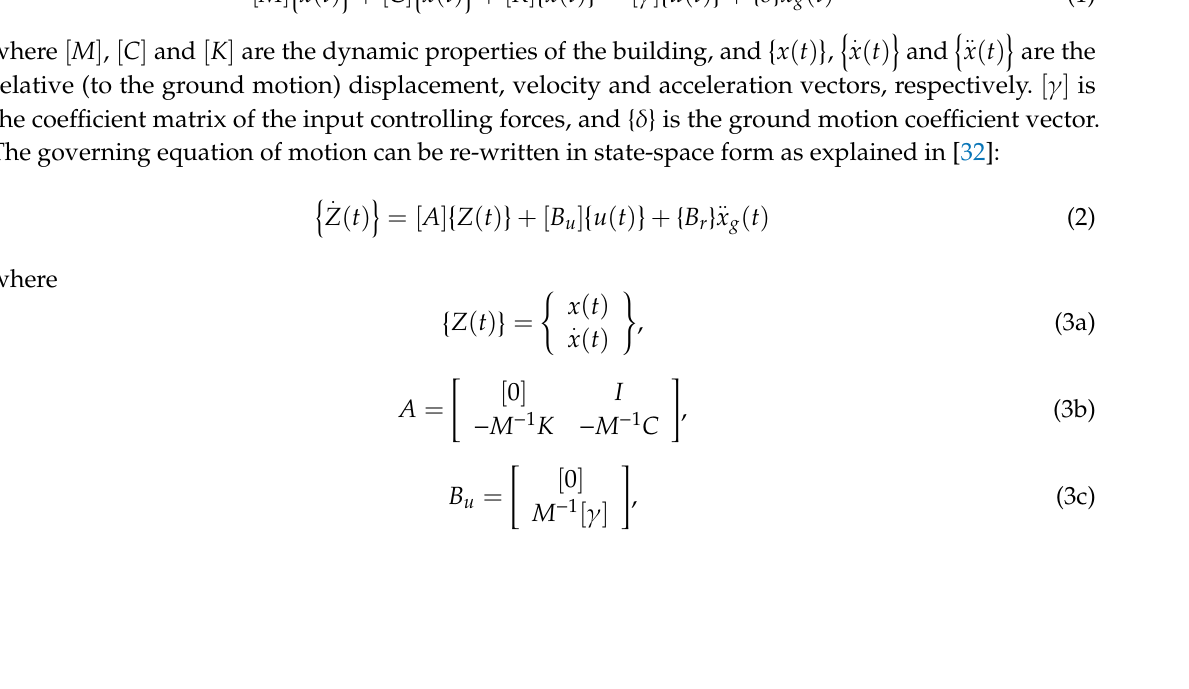
Figure 4. The configuration of the adjacent buildings used in this study.